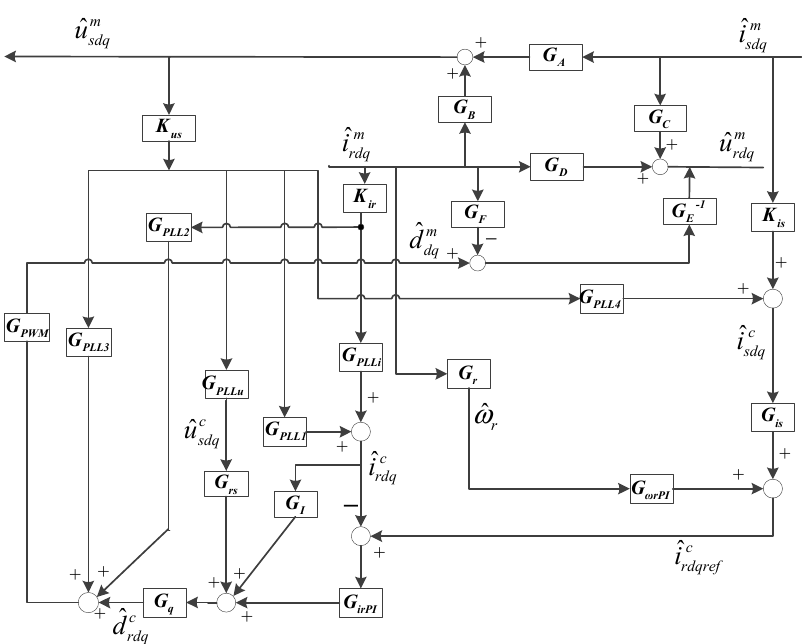
Figure A1. The small-signal transfer diagram of RSC with PLL.